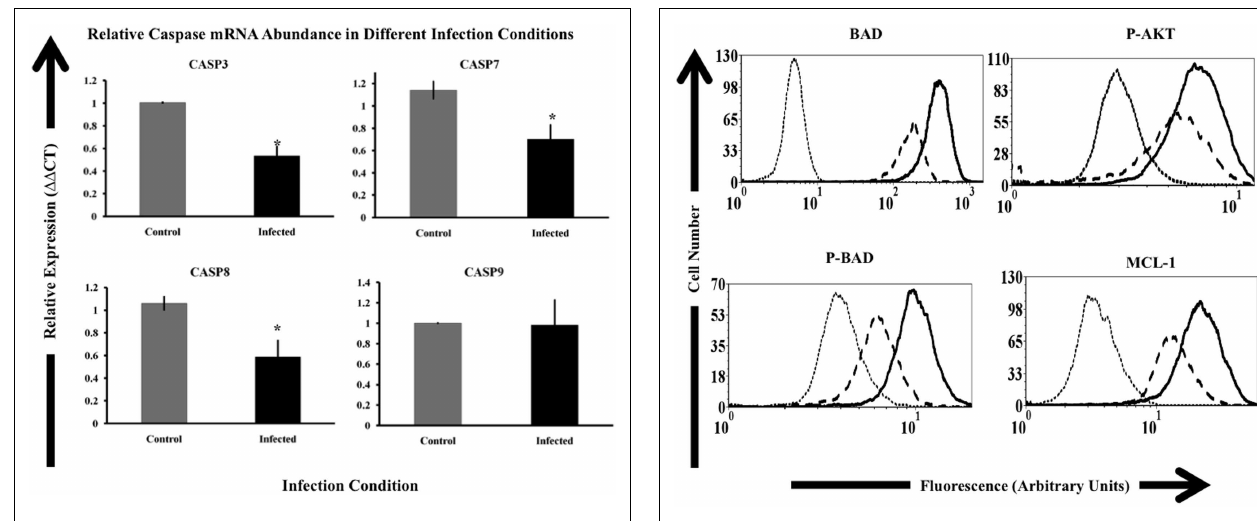
FIGURE 4 | Relative expression of caspase genes in control and MAP-infected macrophages. Abundance of mRNA encoding caspases 3, 7, 8, and 9 was determined via RT-qPCR as described in Materials and Methods.The ∆∆ Ct method was used to determine relative mRNA abundance using beta-actin as the control gene (Livak and Schmittgen, 2001).The uninfected sample (control) is indicated by gray boxes while infected samples are shown as black boxes. Bars represent the average results of MDM cultured from eight healthy Holstein cattle. Error bars represent standard error of the mean (SEM) between the eight biological replicates. Samples marked with a star (*) indicate samples that are significantly different then control samples at p < 0.05.